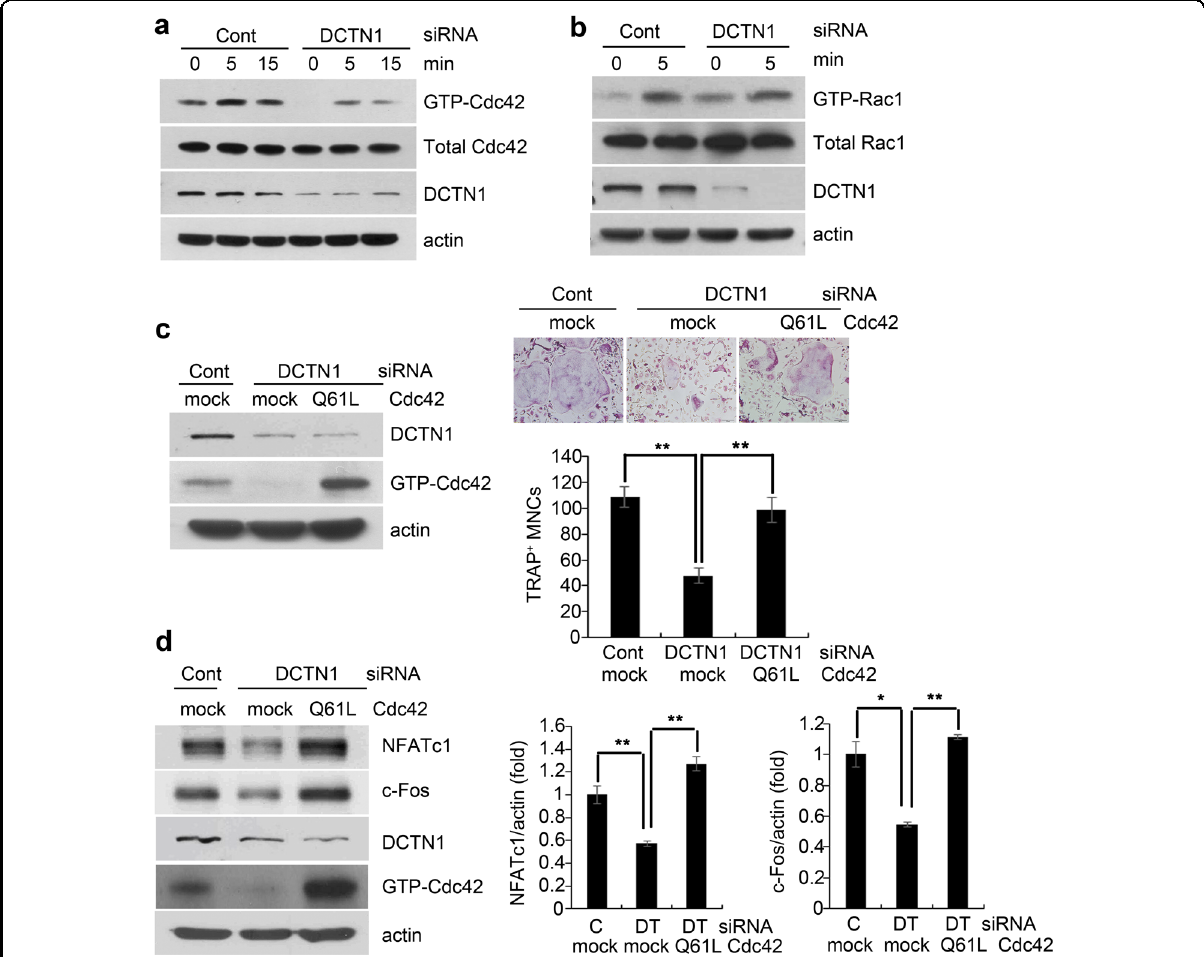
Fig. 3 Cdc42 activity is regulated by DCTN1. a , b BMMs were transfected with control or DCTN1 siRNA. After serum starvation for 4 h, cells were treated with RANKL (400 ng/ml) for the indicated time. The levels of GTP-Cdc42 and GTP-Rac1 were determined by western blotting after active GTP- bound forms of Cdc42 and Rac1 were pulled down. c BMMs transfected with control or DCTN1 siRNA were infected with a retrovirus containing Cdc42 Q61L or control DNA. The cells were then cultured in ODM for 4 days and stained for TRAP. TRAP-positive multinucleated cells were counted. DCTN1 and GTP-Cdc42 protein levels were determined as above. d BMMs transfected with control or DCTN1 siRNA were infected as in C and then cultured in ODM for 48 h. NFATc1 and c-Fos protein levels were determined by western blotting (left panel). NFATc1 and c-Fos mRNA levels were analyzed by real-time PCR (right panel). * p < 0.05, ** p < 0.005 compared with controls. Mock, control pMX vector; Q61L, pMX vector containing constitutively active